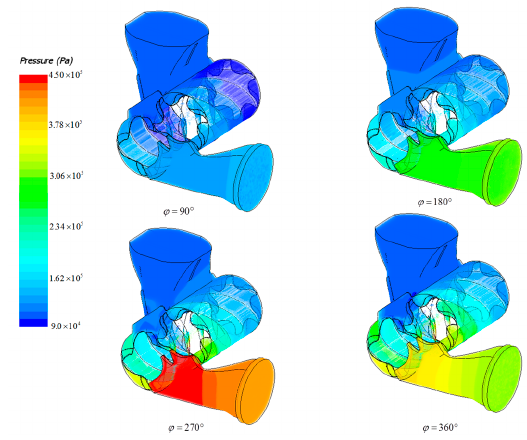
Figure 12. Volume rendering of the pressure distribution according to the angle of rotation. Energies 2017 , 10 , 945